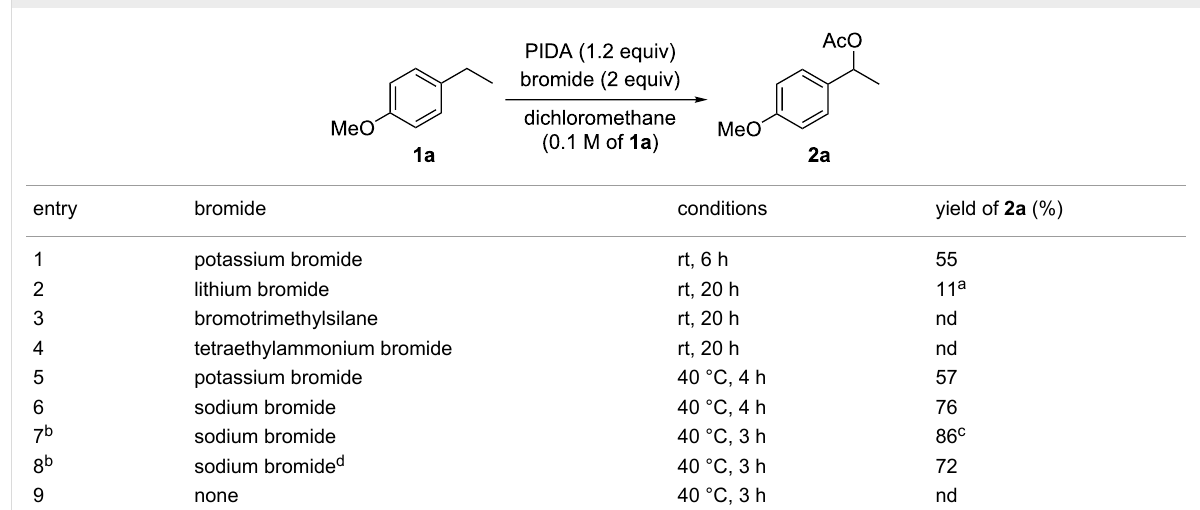
Table 1: Reaction optimization of benzylic C–H acetoxylation using